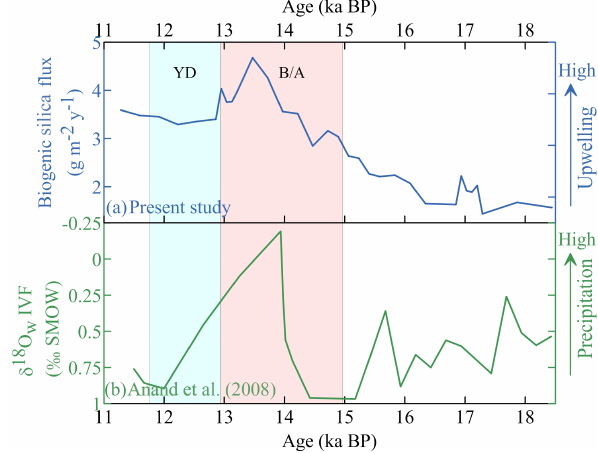
Figure 7. A comparison of the biogenic silica flux with the rainfall record from the eastern Arabian Sea for the pre-Holocene period (18.5–11.7kaBP). (a) The biogenic silica flux (present study) and (b) δ 18 O w IVF (Anand et al., 2008). SMOW stands for Standard Mean Ocean